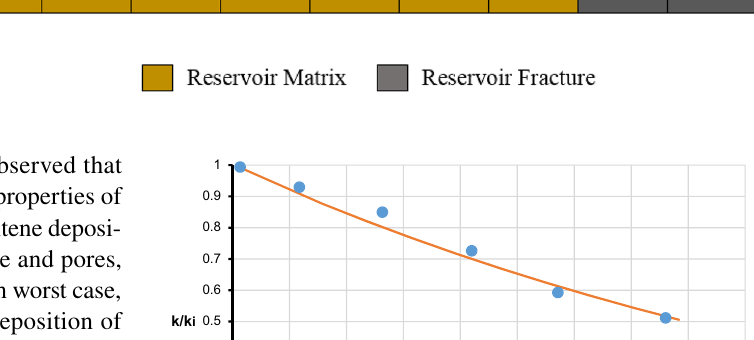
Fig. 4 Schematic of the 1D simulation model used